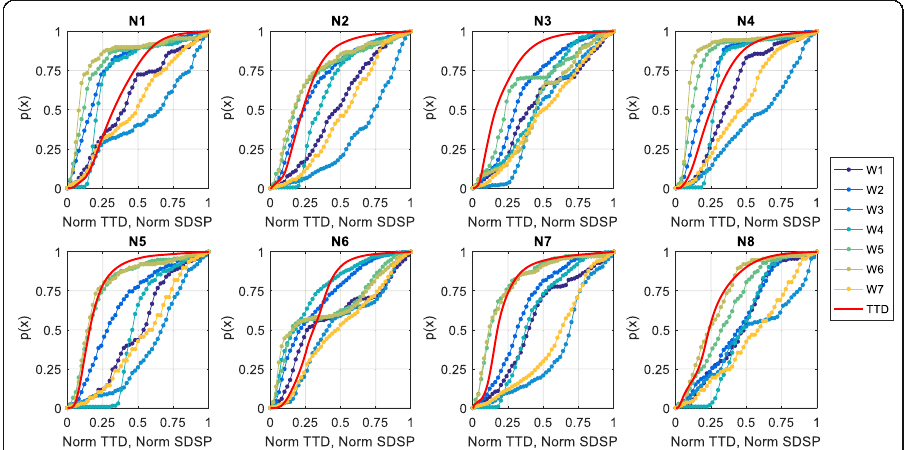
Fig. 2 Comparisons between normalized cumulative frequencies of TTD (Norm TTD) and of SDSP distributions (Norm SDSP), based on 7 different weights, for 8 subnetworks of Dresden ’ s sewer system